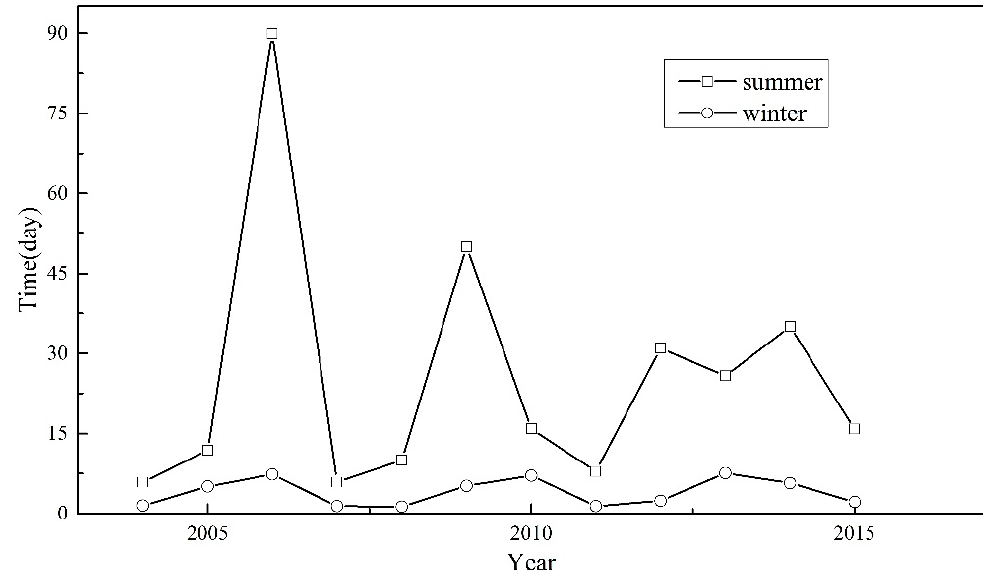
Figure 10. The residence time when 50% of the initial particles remained in Tieshangang Bay in summer and winter (2004–2015).